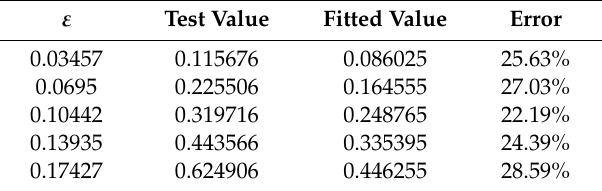
Table 16. The deviation between the test and calculated values for specimen 3 under 200 ◦ C.